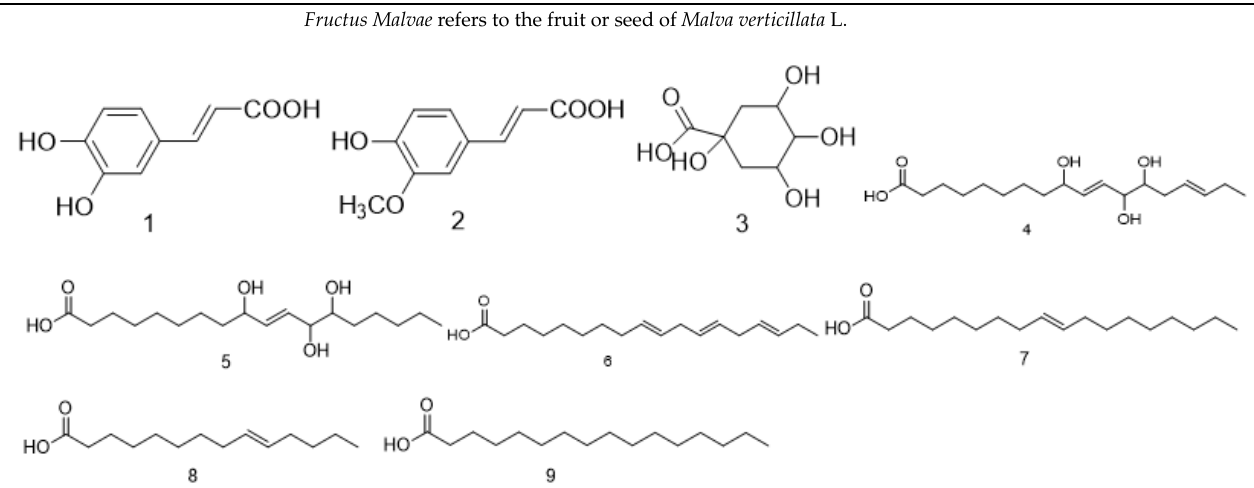
Table 2. The flavonoids identified from Fructus Malvae.